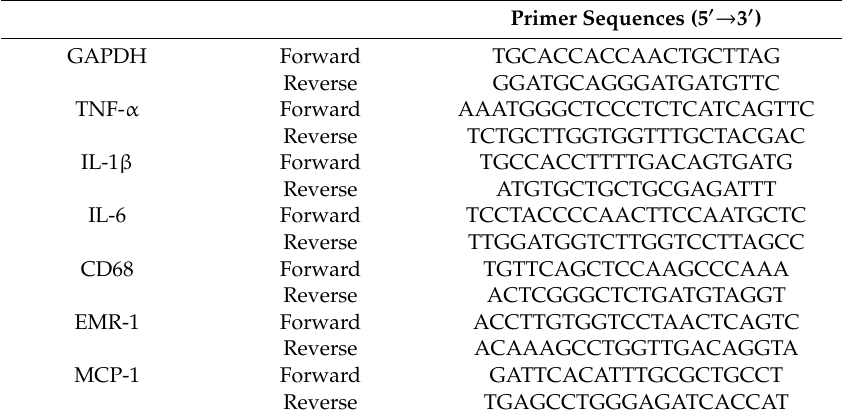
Table 2. Sequences of oligonucleotide primers used in the PCR amplification. Primer Sequences (5 (cid:48) → 3 (cid:48)